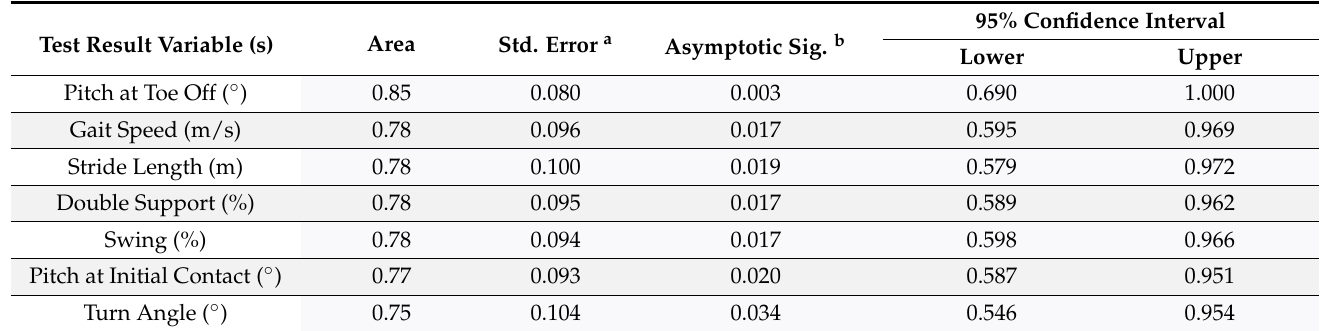
Table 3. The area under the receiver operating characteristic (AUC) curves to classify the instrumented measures of mobility as predictors of future falls.